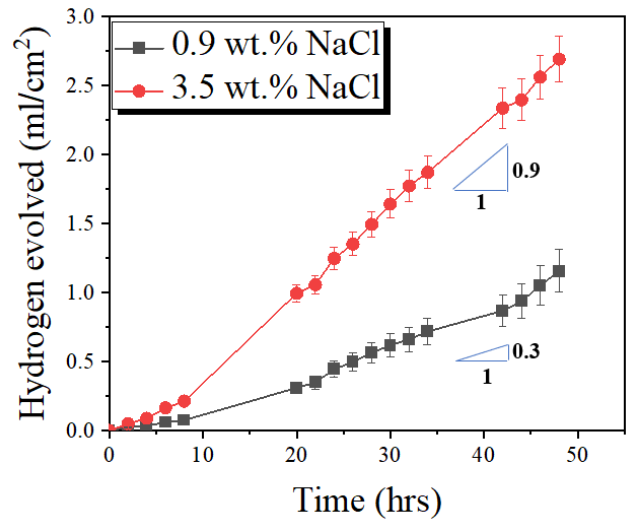
Figure 6. Hydrogen evolution curves of samples immersed in 0.9 wt.% NaCl and 3.5 wt.% NaCl solutions.